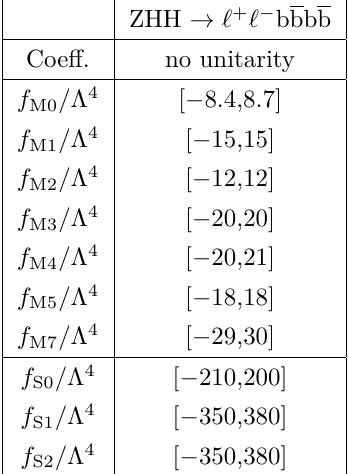
Table 5 . 95% CL lower and upper limits in units of TeV − 4 for the ZHH process for a CMS Run2